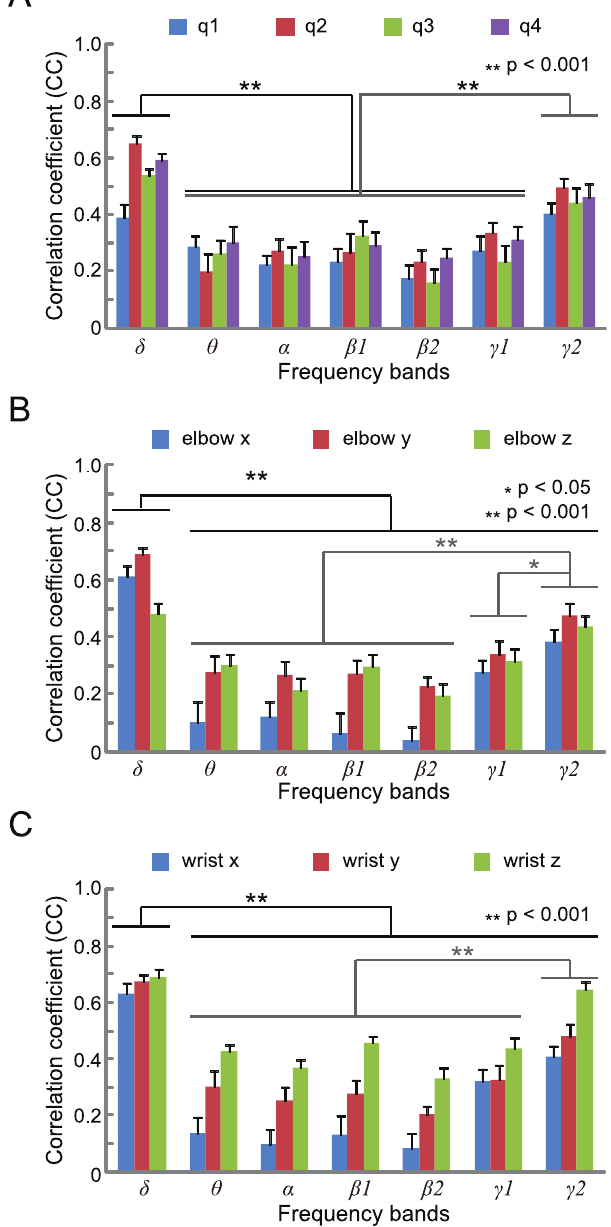
Figure 8. Contribution of each frequency band for trajectory prediction. Each panel (A: joint angles; B: xyz coordinates of the elbow; C: xyz coordinates of the wrist) shows the results of prediction using each sensorimotor rhythm, one by one. Noteworthy significant differences between CC values of frequency bands are marked with * (p , 0.05) and ** (p , 0.001). Other significance comparisons are omitted for visualization purposes.